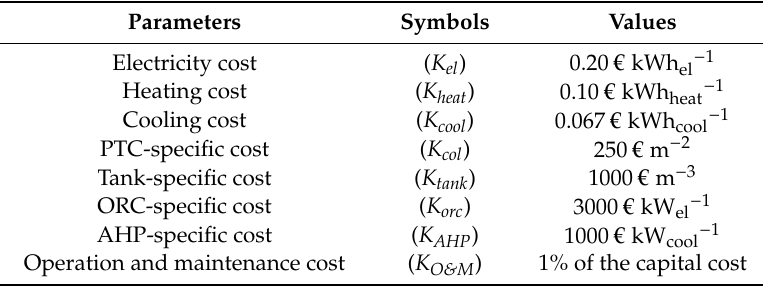
Table 1. Data for financial analysis